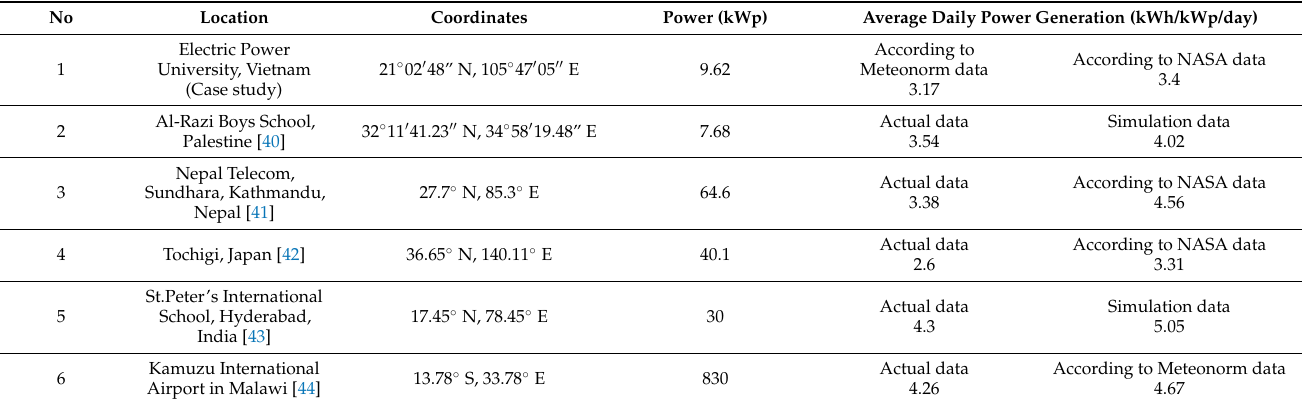
Table 6. Comparison parameters of PV power stations in the